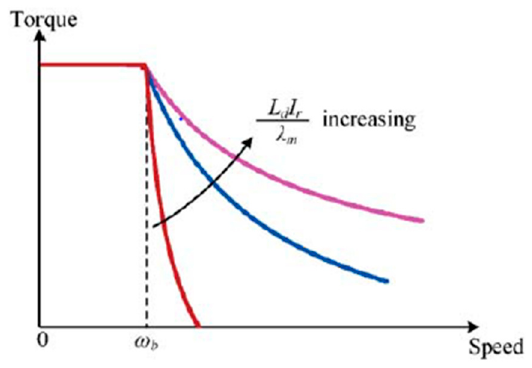
Figure 10. Torque-speed capabilities of flux-weakening control of MMSM [78].